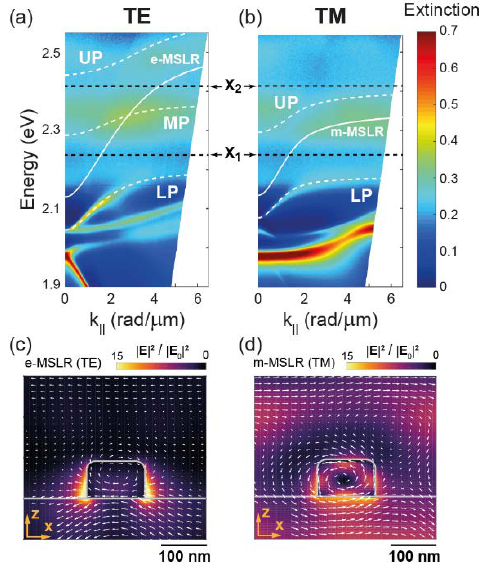
Fig. 2. Extinction in presence of organic dye as function of the incident in-plane moment k || for TE (a) and TM (b) polarizations. The formation of lower, middle and upper polaritons (LP, MP and UP respectively) and their fit (white dashed lines) indicates the strong coupling between the excitons and the MSRLs. In (c) and (d) the spatial distribution of the electric fields shows the electric and magnetic character of the MSLR is shown for each polarization. The color scale represents the intensity of the electric field (| E | 2 /| E 0 | 2 ) and the white arrows represent the vectorial projection of the electric field in the